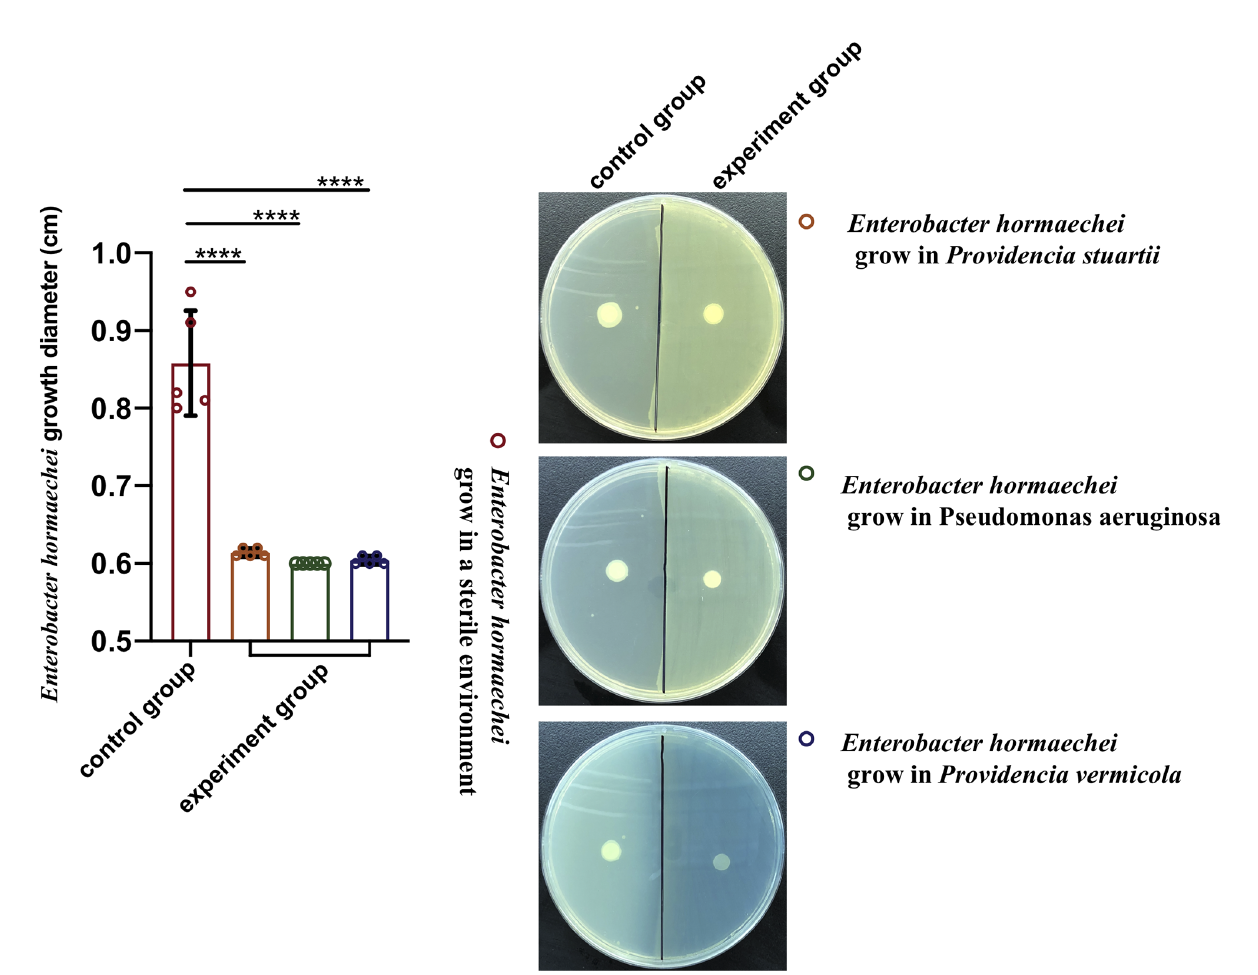
FIGURE 6 | Antagonism experiment of Enterobacter hormaechei and other cultivable bacteria in house fl y larval intestines. Data are shown as the means ± SEM. A t- test was used for the statistical analysis. **** P <